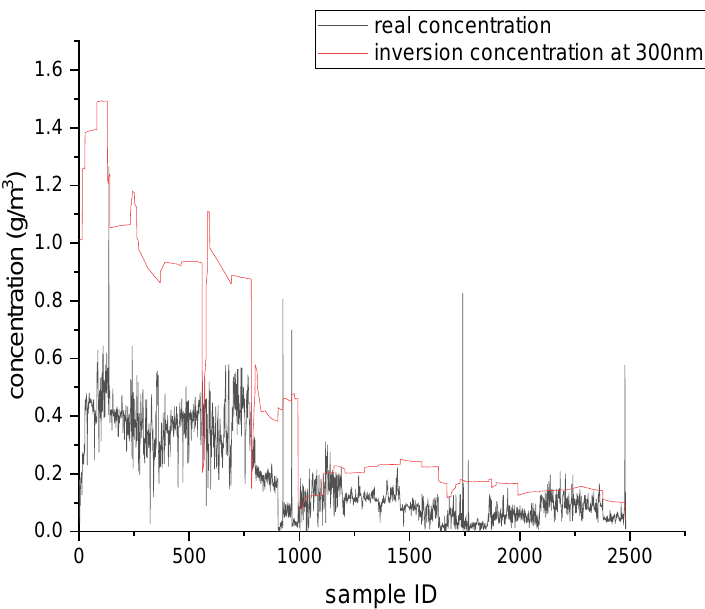
Figure 6. Single-wavelength simulation analysis results for different NO conversion rates at different wavelengths.